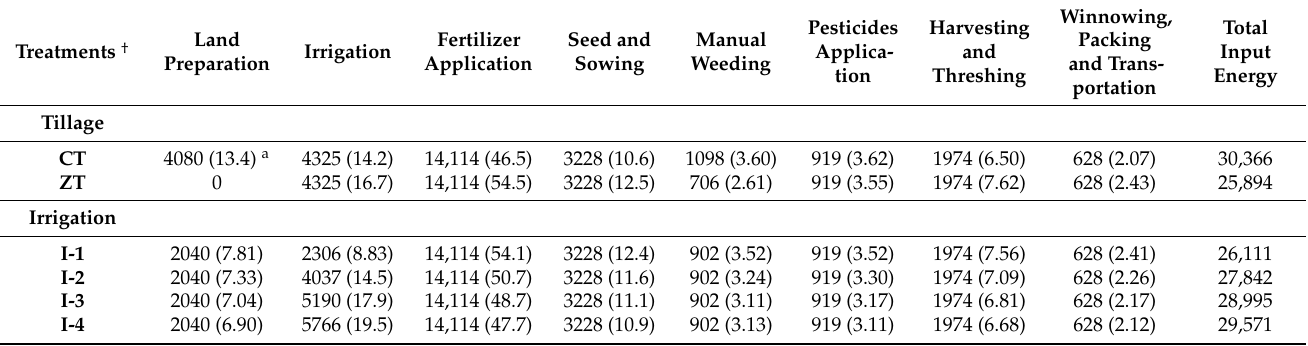
Figure 4. Operation ‐ wise energy input under different tillage and irrigation management practices . Figure 4. Operation-wise energy input under different tillage and irrigation management practices. Table 6. Energy (MJ ha − 1 ) consumption pattern of different management